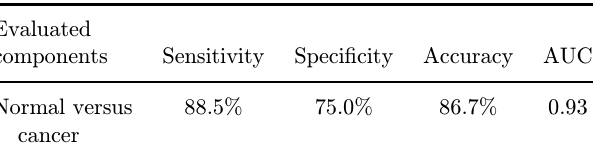
Table 1. Evaluation of the performance of SVM classi¯cation for distinguishing normal and cancerous brain tissues based on (cid:1) .